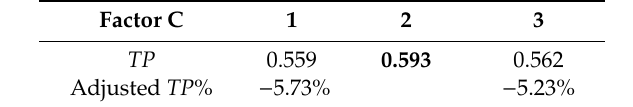
Table 4. The values for the TP and the adjusted TP % resulting from a change in factor C. Factor C 1 2 3 TP 0.559 0.593 0.562